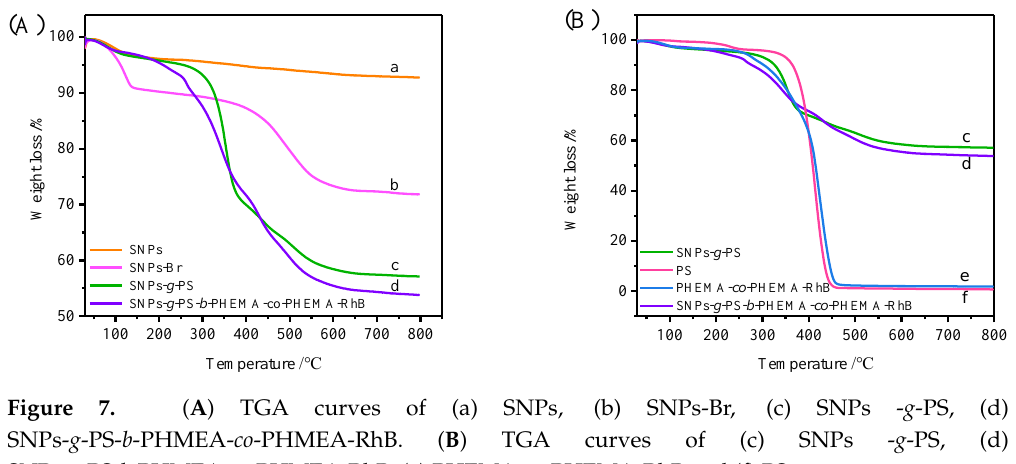
Figure 7. ( A ) TGA curves of (a) SNPs, (b) SNPs-Br, (c) SNPs - g -PS, (d) SNPs- g -PS- b -PHMEA- co - PHMEA-RhB. ( B ) TGA curves of (c) SNPs - g -PS, (d) SNPs- g -PS- b -PHMEA- co -PHMEA-RhB, (e) PHEMA- co -PHEMA-RhB and (f) PS. Figure 8 presents the fluorescence of SNPs- g -PS- b -PHMEA- co -PHMEA-RhB and PHMEA- co -PHMEA-RhB formed in solution, and the images of the dispersions of SNPs (a1, a2, a3), SNPs-Br (b1, b2, b3), SNPs- g -PS (c1, c2, c3), SNPs- g -PS- b -PHMEA-co-PHMEA-RhB (d1, d2,